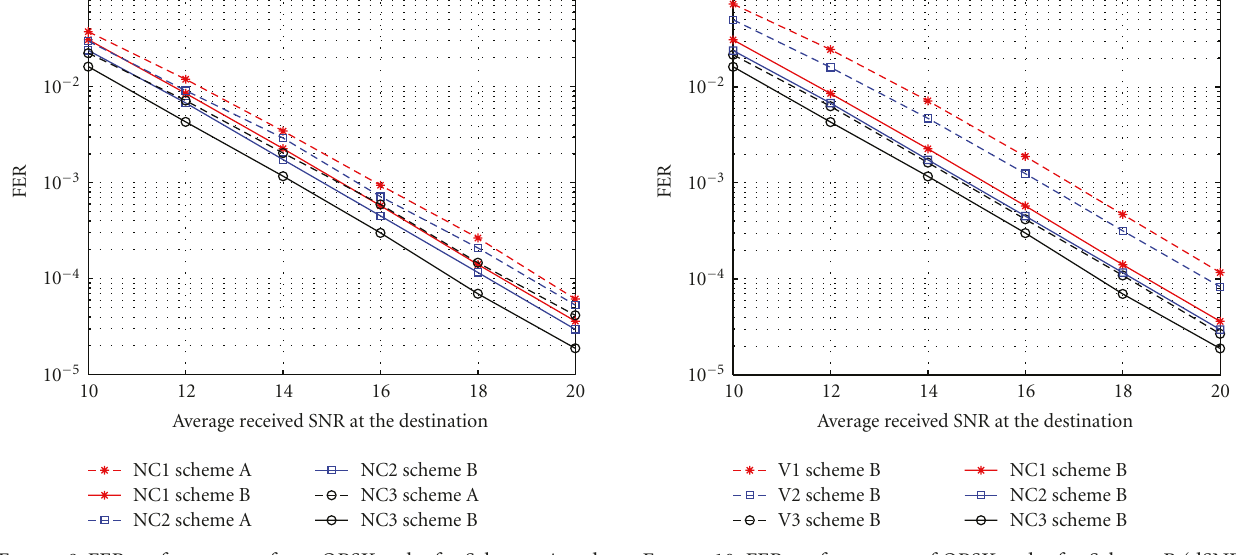
Figure 8: FER performances of new QPSK codes for Schemes A and B (dSNR = 10dB).